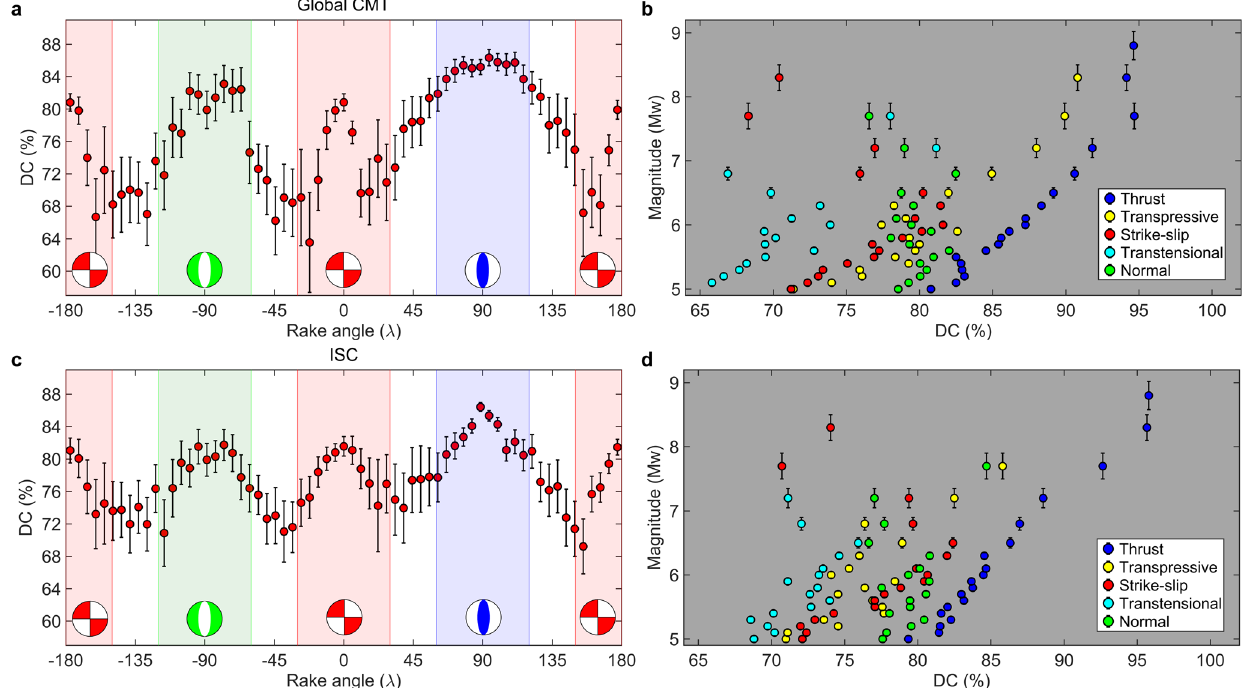
Fig. 1 Trends of double-couple component of the seismic moment tensors. Results for the GCMT and ISC catalogues are shown in panels ( a , b and c , d ) respectively, also with respect to different magnitude bins. Seismicity is classi fi ed into normal (green), strike-slip (red), thrust (blue) according to the Aki- Richards de fi nition 29 , while transpressive and transtensional events are respectively in yellow and in cyan, as represented in the legends on the right panels. Error bars in ( a , c ) stand for 2 σ